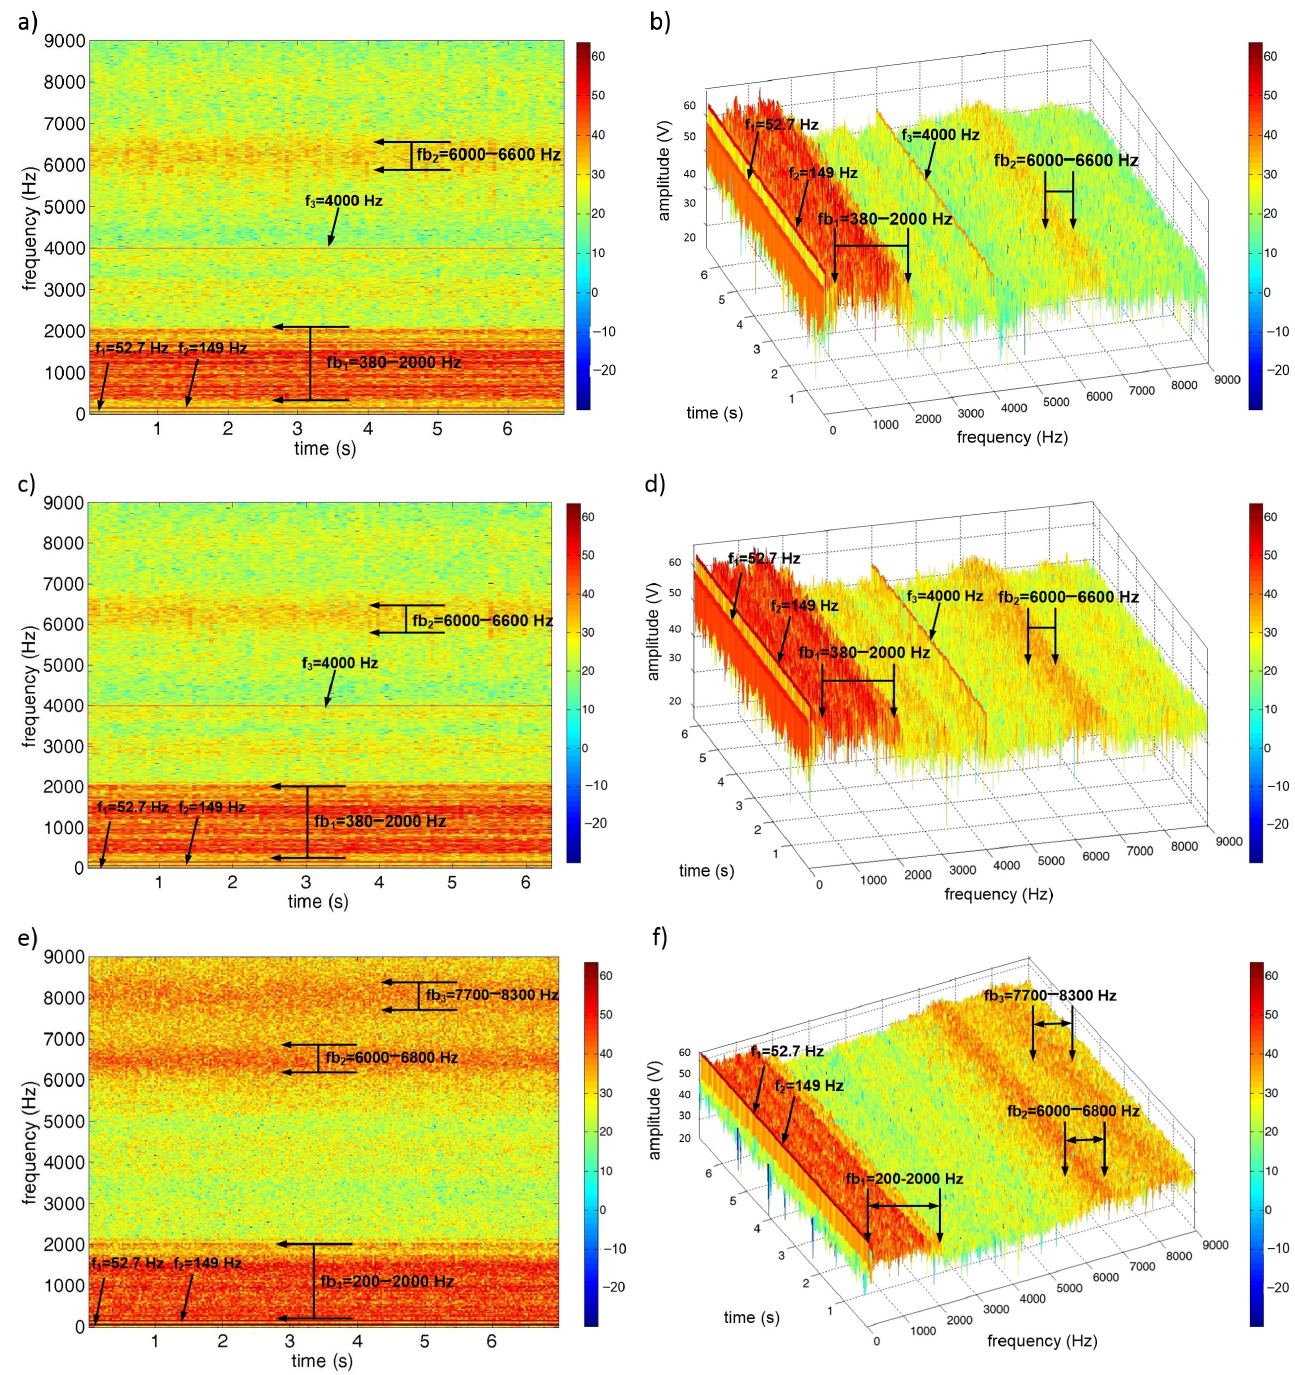
Figure 15. Spectrograms of vibration signals of acceleration (( a ) three aggregates without drill bit—2D view, ( b ) three aggregates without drill bit—2D view, ( c ) three aggregates with drill bit—2D view, ( d ) three aggregates with drill bit—2D view, ( e ) andesite rock disintegration—2D view, ( f ) andesite rock disintegration—3D